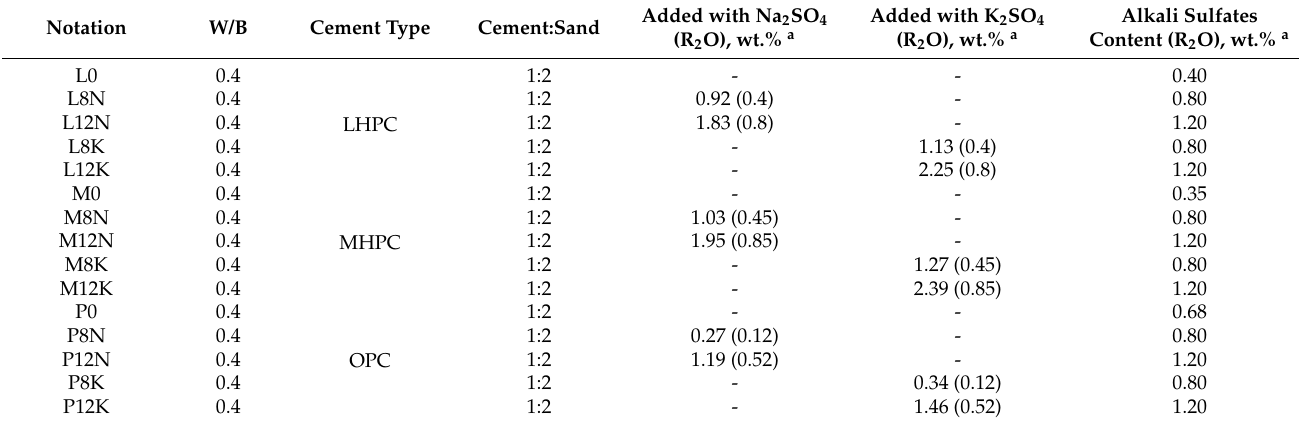
Table 2. Mix proportions and notations of